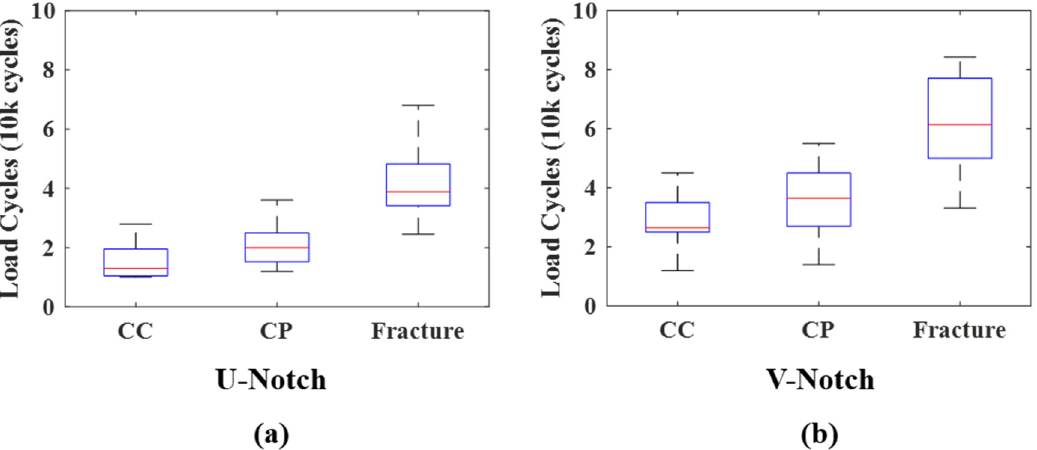
Figure 11. Distribution of the total fatigue life (or load cycles) in the CC, CP, and fracture regimes with respect to the total number of load cycles for the ( a ) U-notched; ( b ) V-notched specimens. The red lines denote the medians of the distribution.